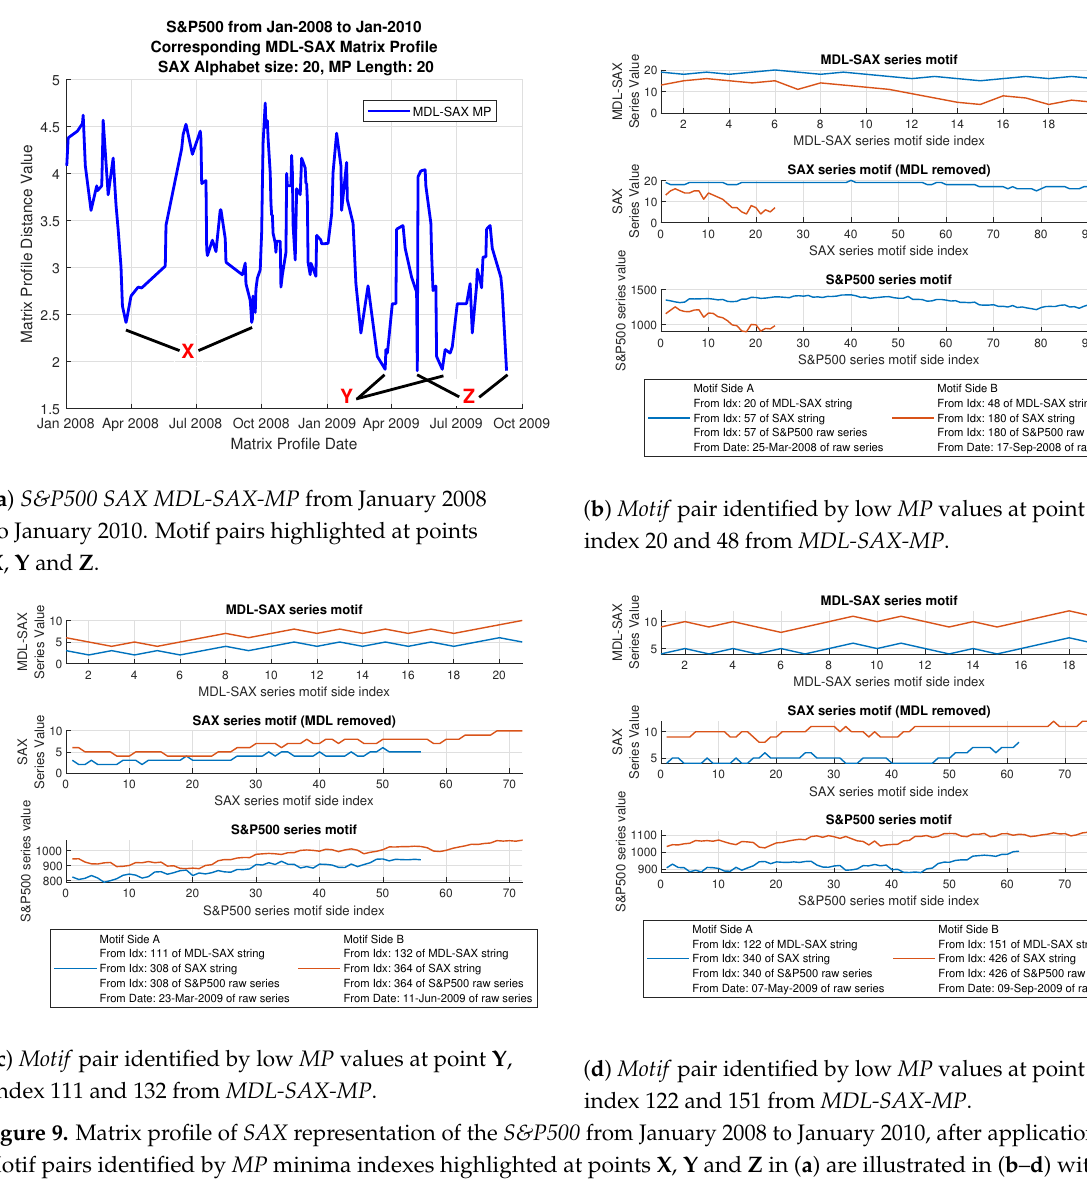
Figure 9. Matrix profile of SAX representation of the S&P500 from January 2008 to January 2010, after application of MDL . Motif pairs identified by MP minima indexes highlighted at points X , Y and Z in ( a ) are illustrated in ( b – d ) with variable lengths per motif side illustrated in both the SAX (middle) and raw data (bottom)